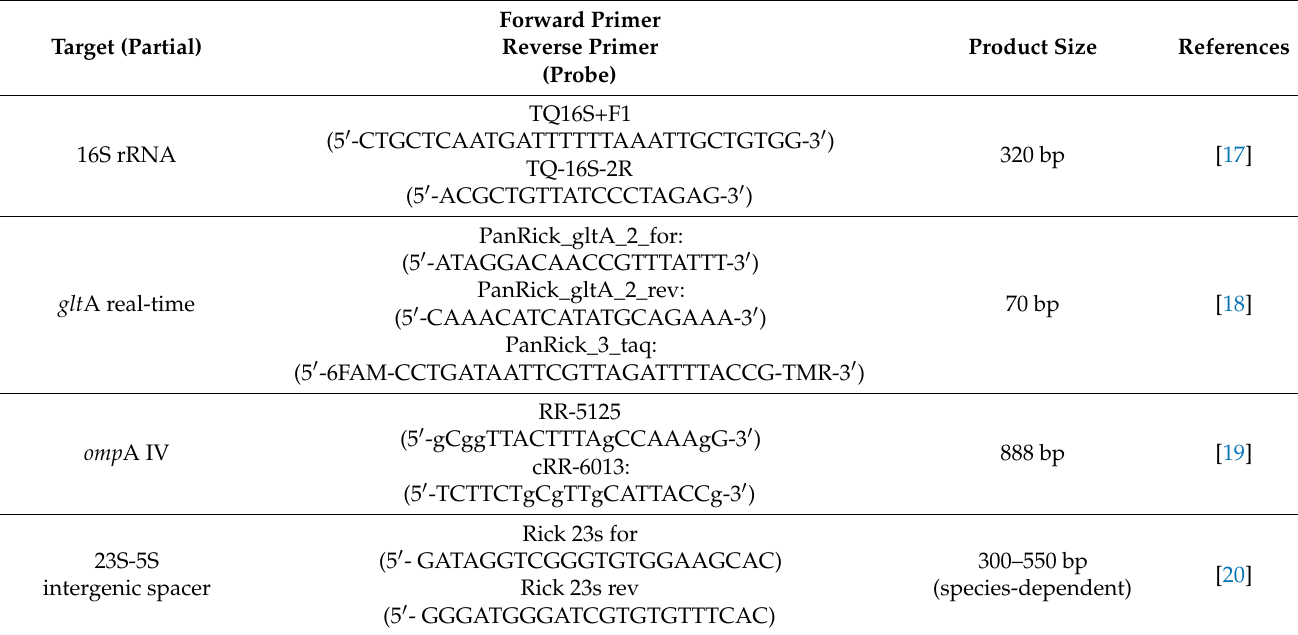
Table 1. Primers and Probes used for molecular investigation in this study.